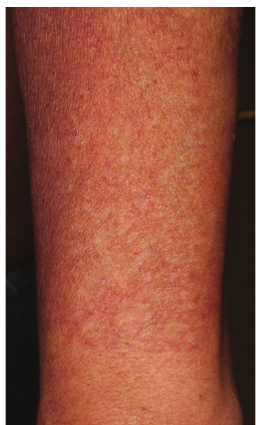
Figure 2: Clinical presentation of acquired brachial cutaneous dyschromatosis. Closer inspection of the left forearm reveals hyper- pigmented patches and hypopigmented, slightly depressed, atrophic plaques with prominent telangiectasia. Note the relative sharp demarcation at the distal forearm/wrist.